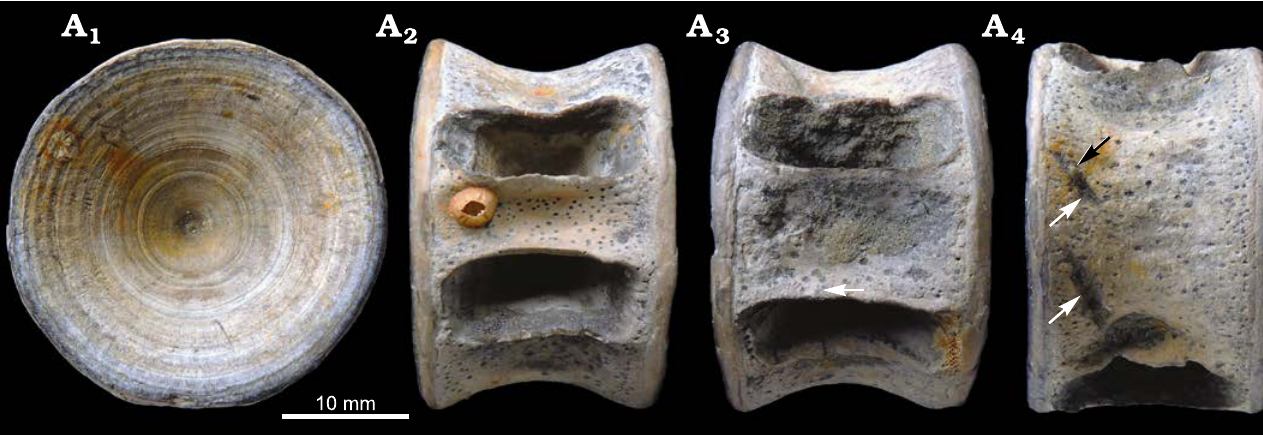
Fig. 4. Centrum of a carcharhinid shark, cf. Galeocerdo aduncus (Agassiz, 1843) (CMM-V-6761), from the Miocene St. Marys Formation in Lusby, MD, USA. Centrum in aricular (A 1 ), dorsal (A 2 ), ventral (A 3 ), and lateral (A 4 ) views. Parallel bite traces are visible in A 4 (white arrows), broken tooth is indi- cated by black arrow. The adhered barnacle and bryozoan are Recent taxa not contemporaneous with the